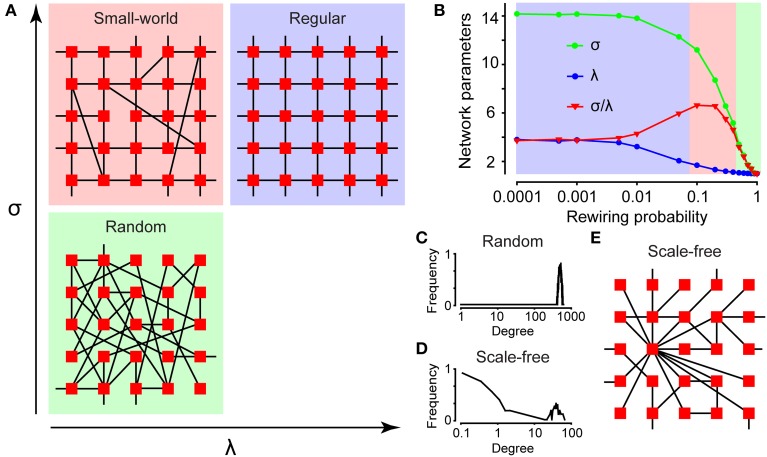
Characterizing network structures. (A) The topologies of a small-world (red), regular (blue), and random (green) network depicted with their internal relations to the network parameters σ and λ. (B) The network parameters σ and λ for a small-world (red), regular (blue), and random (green) network, plotted as a function of rewiring. The degree distributions for a random (C) and scale-free (D) network plotted in a log–log scale. (E) The topology for a scale-free network.